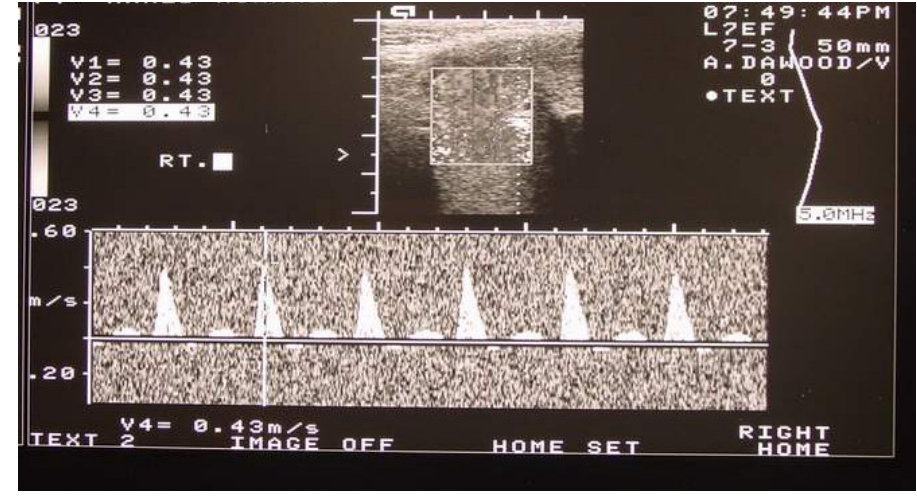
FIGURE 1. Color Doppler US of the proximal penis. PSV is high (43 cm/s), but a fistula or a pseudoaneurysm could neither be demonstrated nor